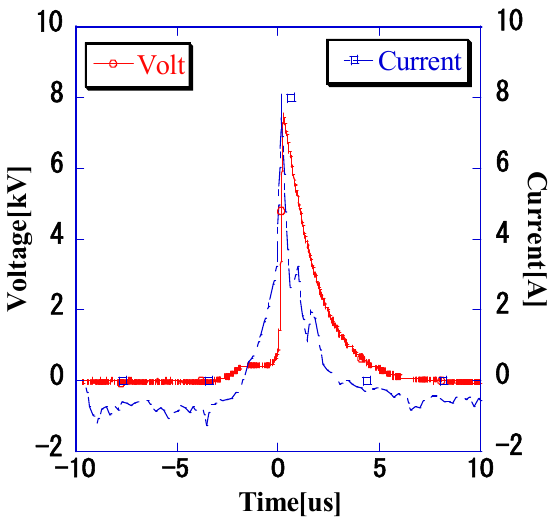
Figure 7. Voltage and current waveforms at a pulse width of 1.7 µ s. The shape of the voltage and current waveforms are similar.